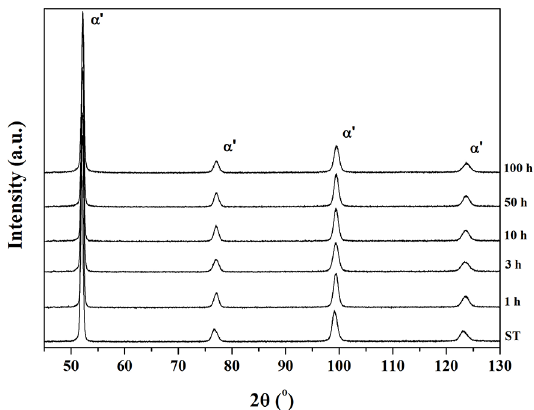
Figure 1. XRD patterns of solution-treated and aged Maraging-300 steel specimens.